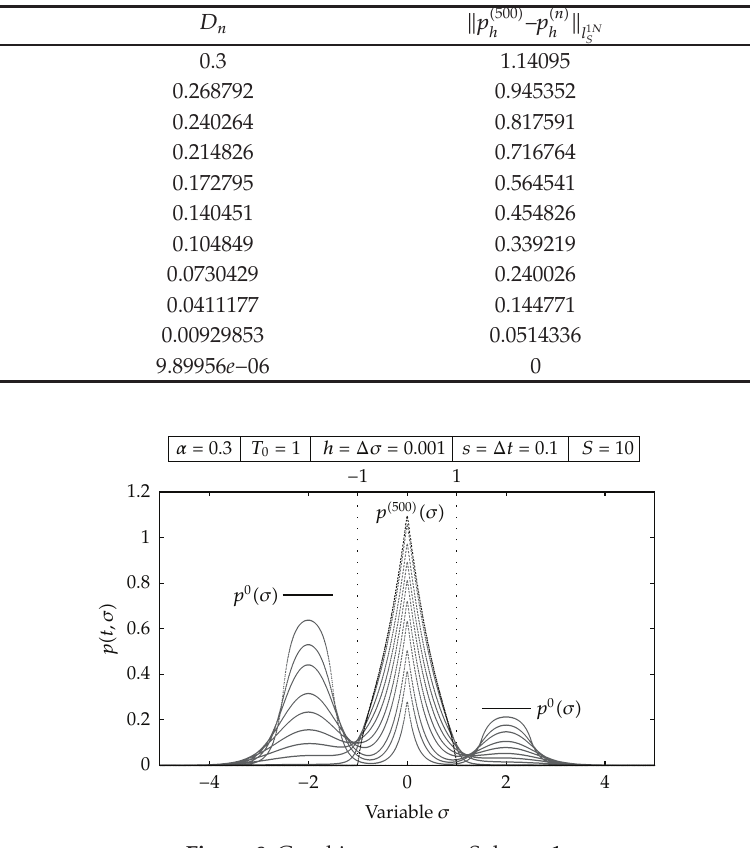
Table 6: Numerical results: Subcase 1.